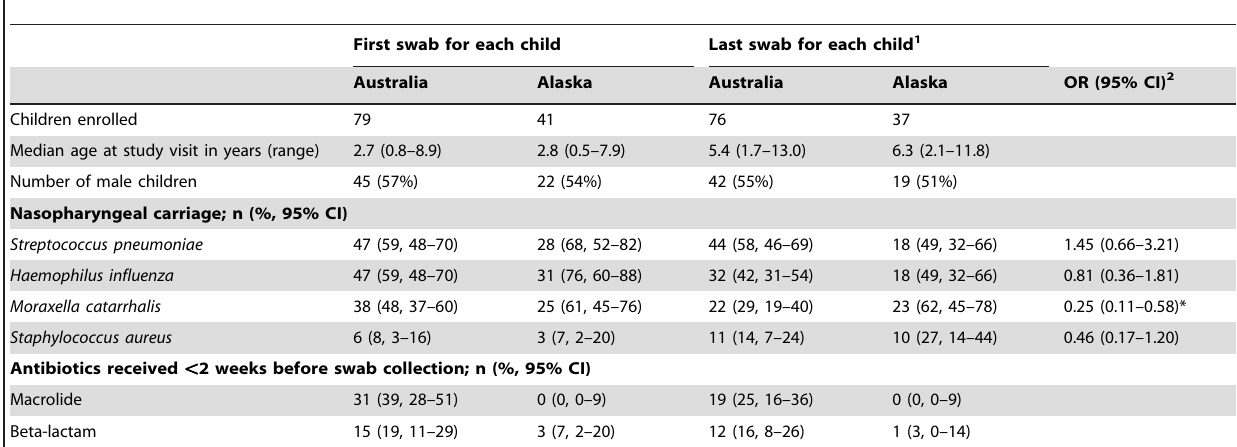
Table 2. Nasopharyngeal carriage of respiratory bacteria from Australian and Alaskan children at baseline and end of study.